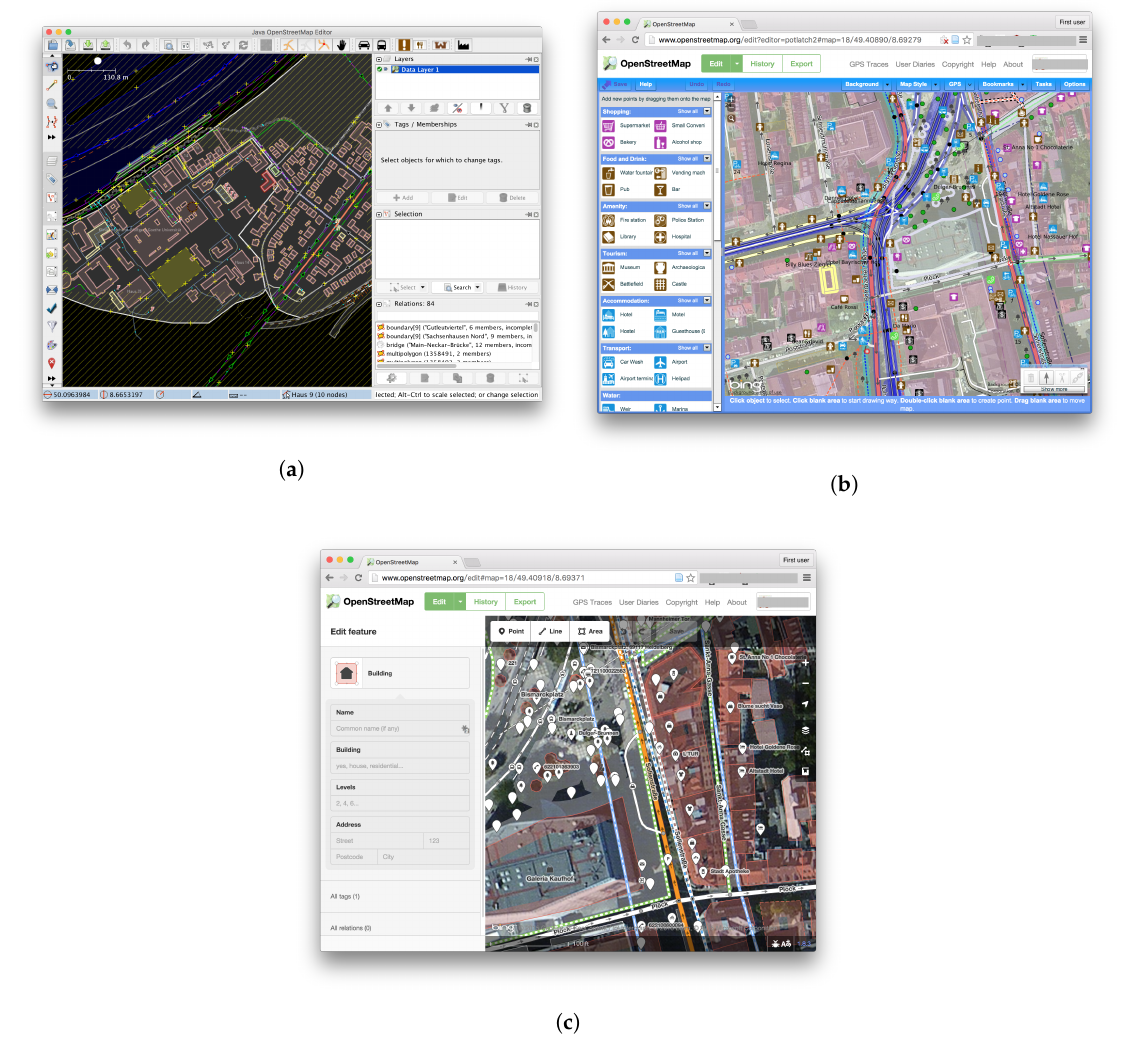
Figure 1. Major OSM editors. ( a ) JOSM; ( b ) Potlatch; ( c )